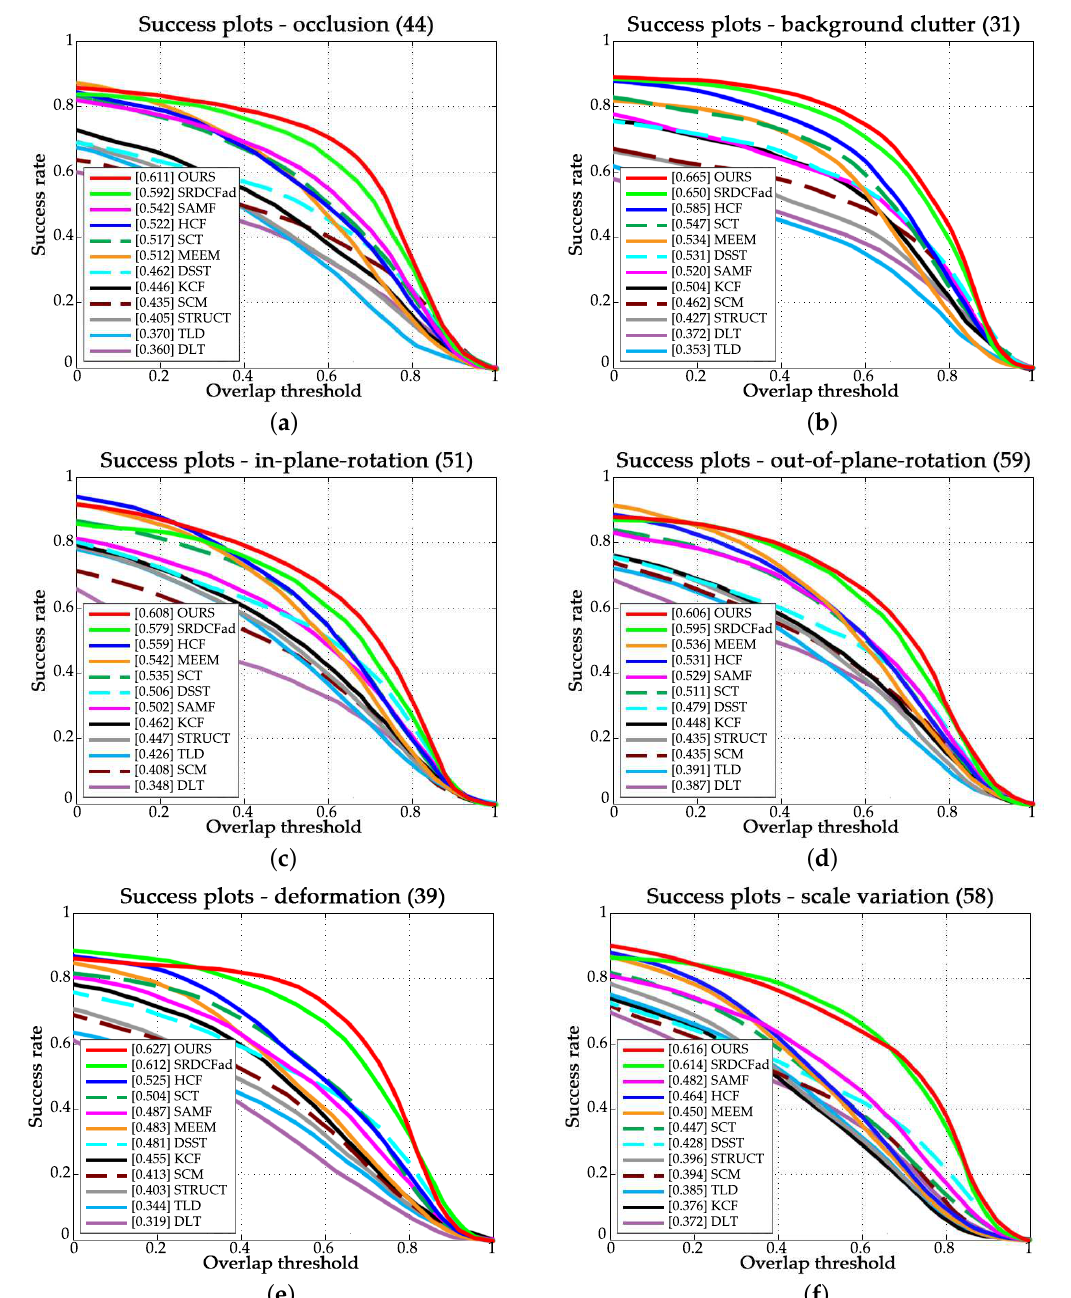
Figure 5. Success plots over six tracking challenges of ( a ) occlusion; ( b ) background clutter; ( c ) in-plane rotation; ( d ) out-of-plane; ( e ) deformation; and ( f ) motion